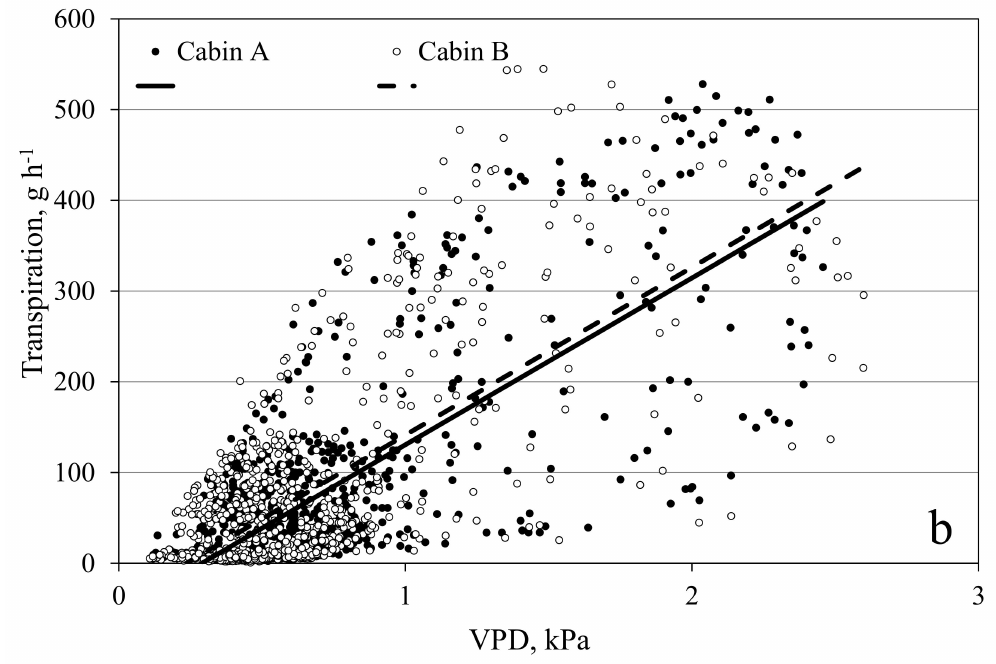
Figure 10. Transpiration of a tomato crop measured in the open chamber mode a ff ected by global radiation ( a ) and vapor pressure deficit (VPD) ( b ). Data shows hourly averages of measurements in the period from 1 April to 16 May 2016. Leaf area index increased during this period from 1.5 to 2.2 m 2 m − 2 . Air temperature ranged between 15 ◦ C at night and 30 ◦ C in the middle of sunny days. The continuous and dotted lines depict the empirical quadratic ( a ) and linear ( b ) response curves fitted with the data of the two cabins separately.